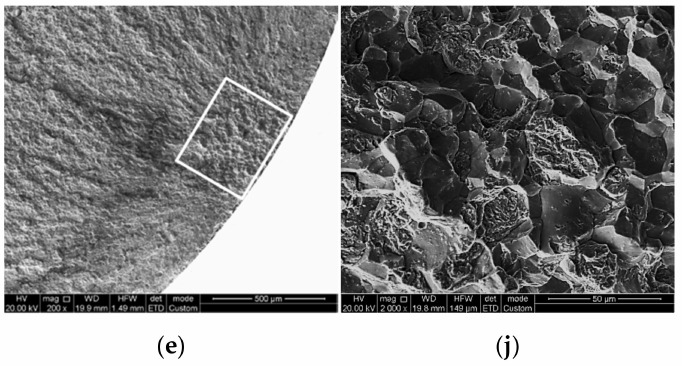
Figure 8. SEM fractographs showing ( a – e ) low-magnification overviews, and ( f – j ) crack initiation sites of fracture surfaces of the specimens austenitized at different temperatures of ( a , f ) 820 ◦ C, ( b , g ) 840 ◦ C, ( c , h ) 860 ◦ C, ( d , i ) 880 ◦ C, and ( e , j ) 900 ◦ C.